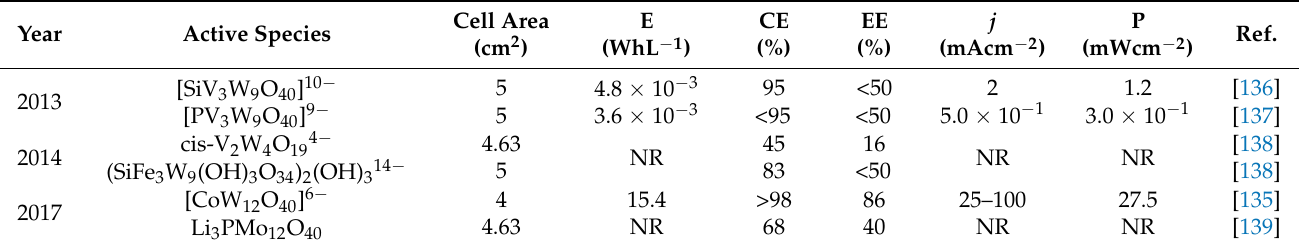
Table 4. Parameters of POM-based RFBs reported since 2013.